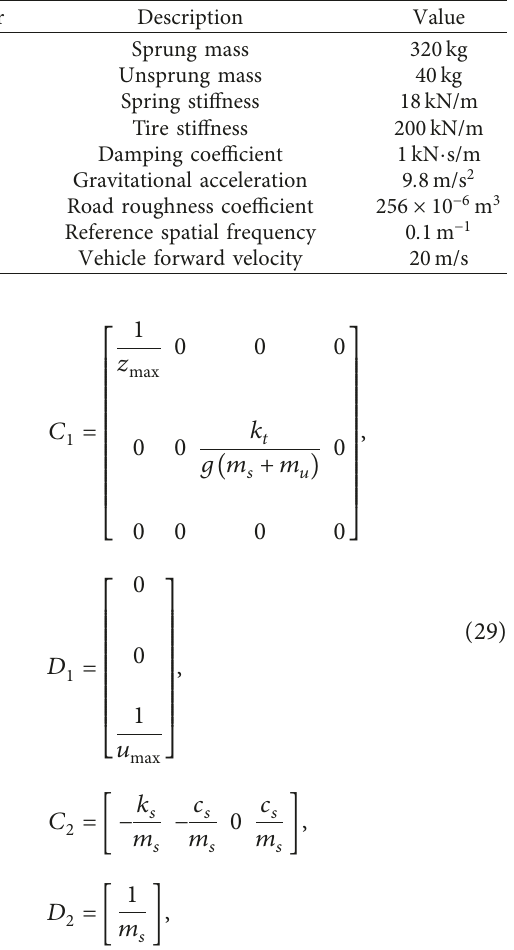
Table 1: Quarter-car suspension parameters. Table 2: Reference actuator fault.